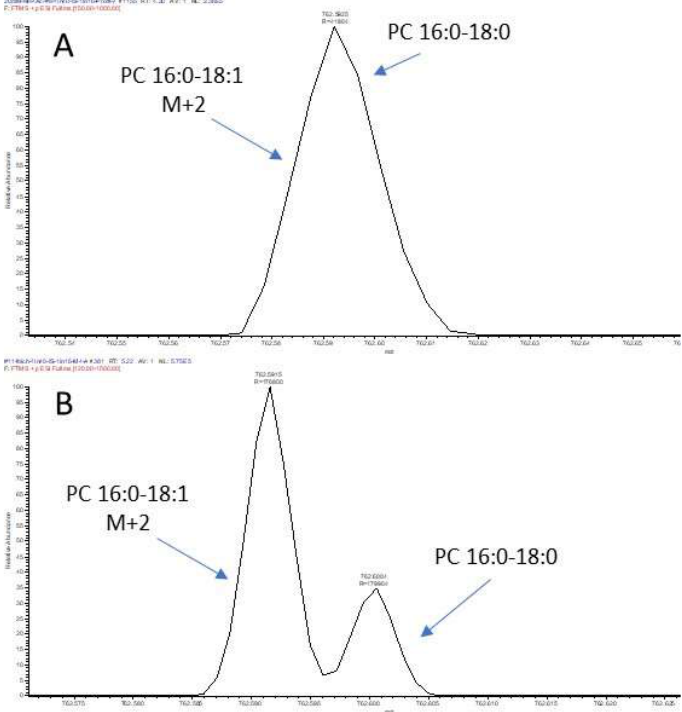
Figure 5. Mass separation of M+2 isotope of PC 34:1 ( m / z 762.5923) and monoisotopic ion of PC 34:0 ( m / z 762.6013) by Orbitrap Elite at two resolution settings. ( A ): 60,000; ( B ): 240,000.